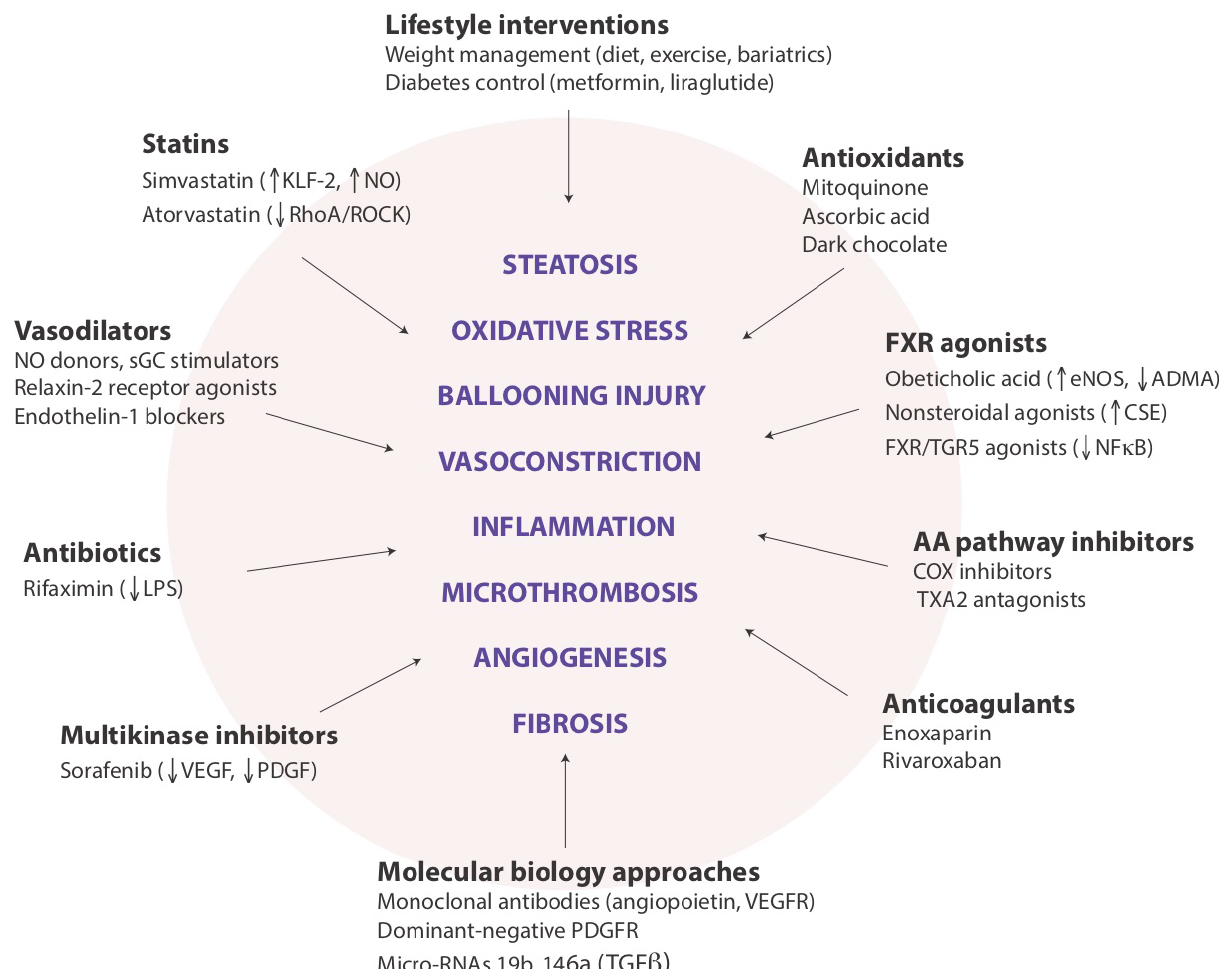
Figure 6. Potential targets for modulating intrahepatic vascular resistance in NAFLD. Schematic summary of lifestyle and pharmaceutical interventions aimed at sinusoid pathophenotypes that may contribute to the development of portal hypertension in NAFLD. While several drugs are already in clinical use for other indications, most remain in the experimental phase, and none has been approved explicitly for the prevention or reduction of portal hypertension. COX: cyclooxygenase; CSE, cystathionase; eNOS: endothelial nitric oxide synthase; KLF-2: Kruppel-like factor-2; LPS: lipopolysaccharide; NF-κB: nuclear factor kappa B; PDGF: platelet-derived growth factor; PDGFR: PDGF receptor; RhoA/ROCK: Ras homolog family member A/ Rho-associated coiled-coil protein kinase; sGC: soluble guanylyl cyclase; TGR5: Takeda G protein coupled receptor 5; TNFα: tumor necrosis factor-alpha; TXA2: thromboxane A2; VEGF: vascular endothelial growth factor; VEGFR: VEGF - -